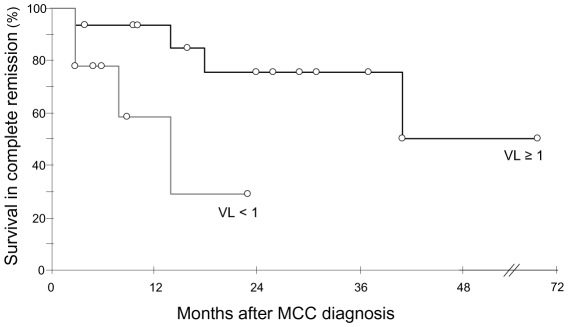
Kaplan Meier analysis of survival in complete remission relative to primary tumour MCPyV load.Patients with ≥1 genome copy per cell (n = 15, black curve) had longer survival in complete remission than patients with <1 genome copy per cell (n = 9, grey curve). VL : viral load. Open circles indicate patients censored at last follow-up visit.